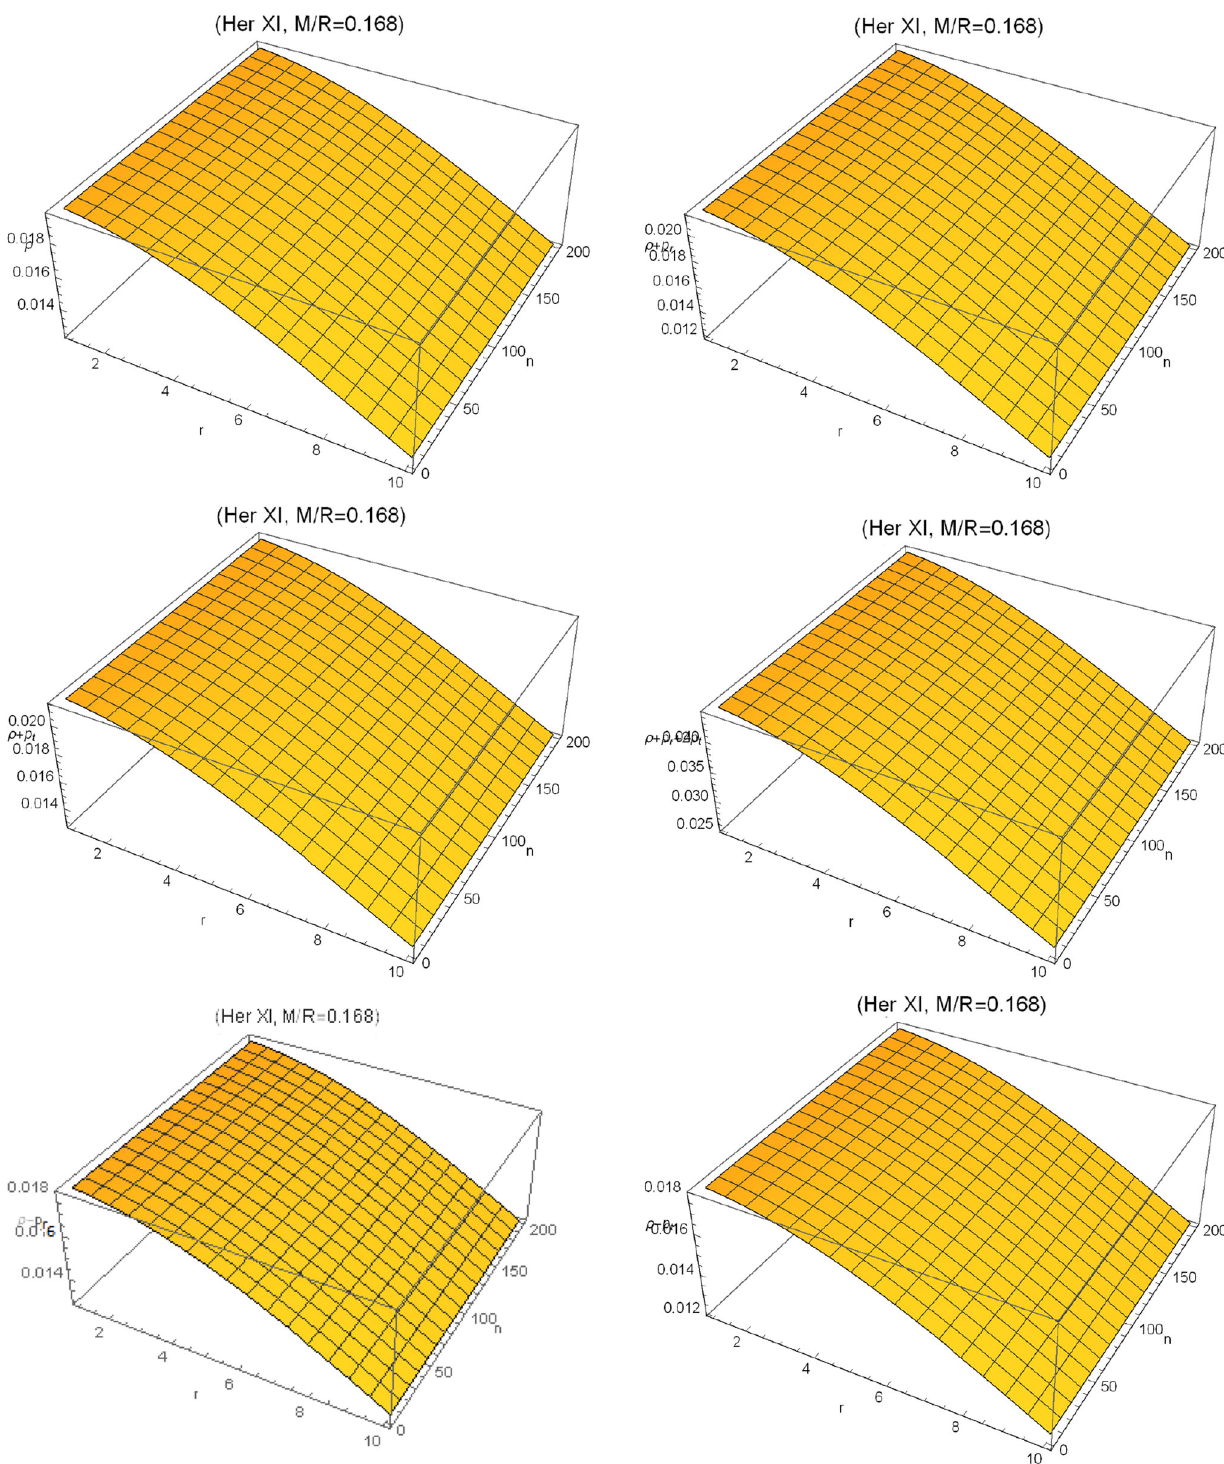
Fig. 8 Energy conditions for compact star Her X1 with radial coordinate r (km) and model parameter